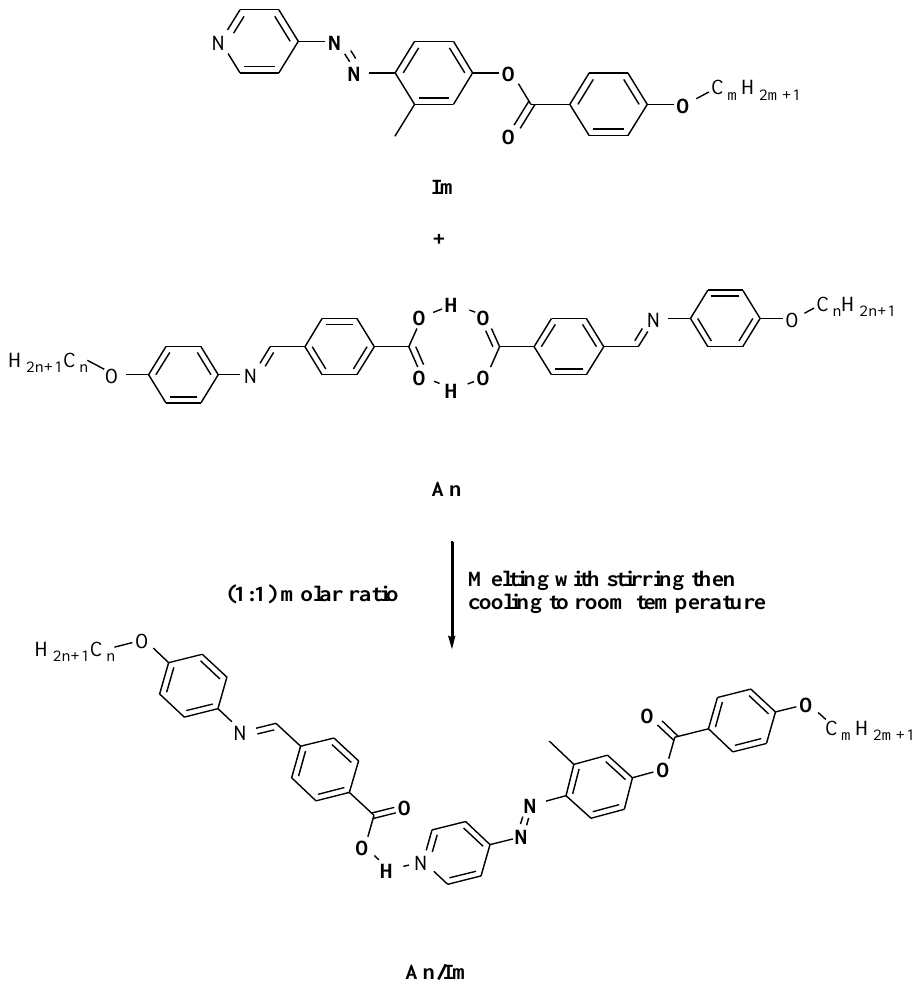
Figure 9. Molecular electrostatic potentials (MEP) for SMHBCs, An/Im